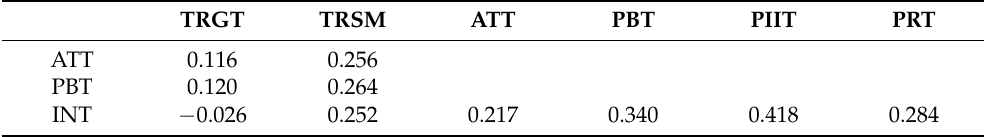
Table 5. Direct effect in the structural model.